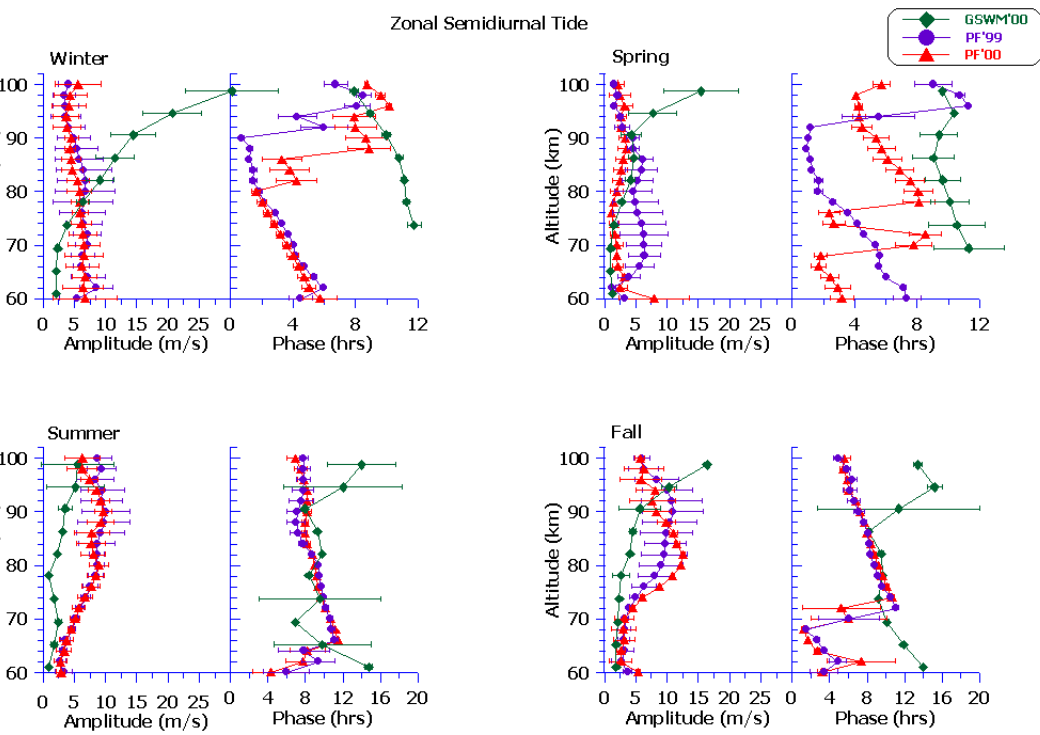
Fig. 6. Semidiurnal seasonal mean for summer, winter, spring, and fall of the Poker Flat radar data (zonal component) and the GSWM00 values. Data shown are for the years 1999 and 2000. Horizontal bars represent the standard errors.